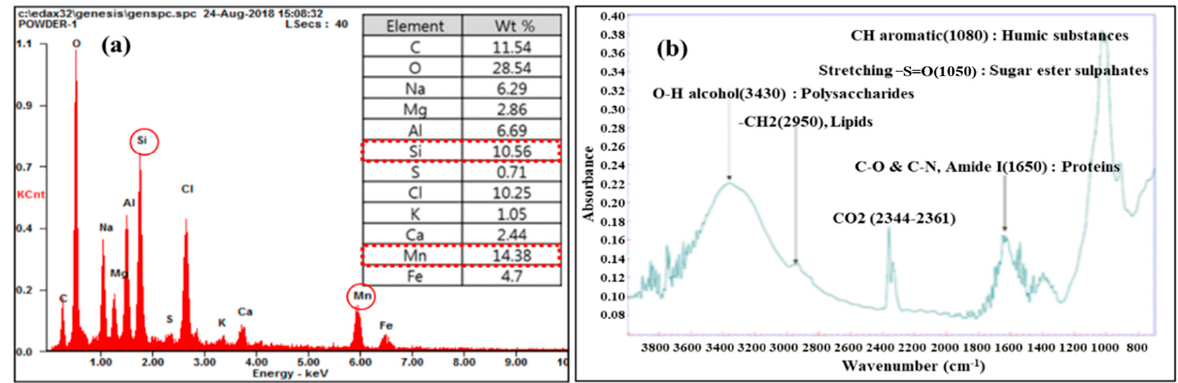
Figure 9. Analysis of raw water quality at the time of rapid TMP increase in the MF-alone process: ( a ) EDS and ( b ) FTIR .